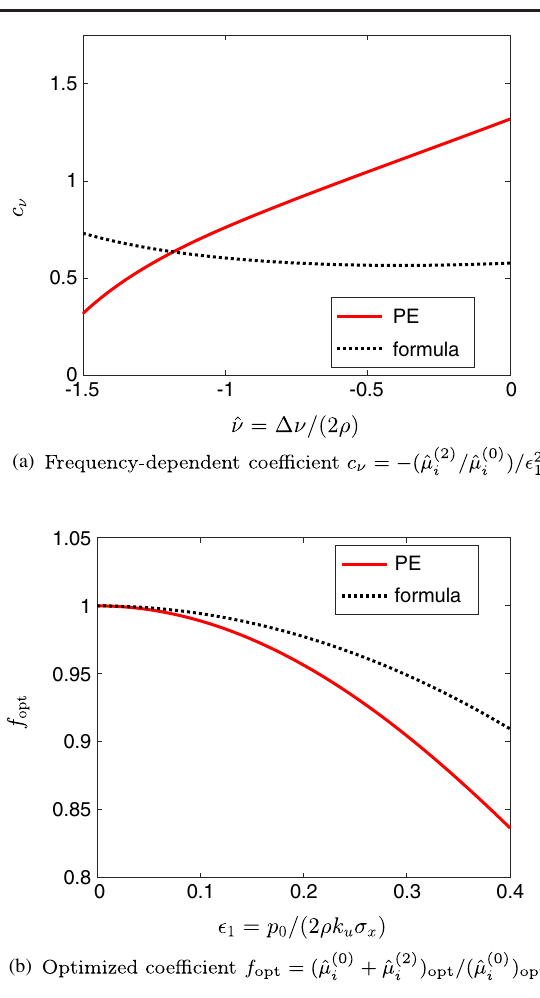
FIG. 5. Comparison of the periodic analysis (PE) results with the estimates derived from the Tanaka formula [Eq. (1)] for β 30 m. A stronger-than-anticipated reduction of the growth ex ¼ rate is